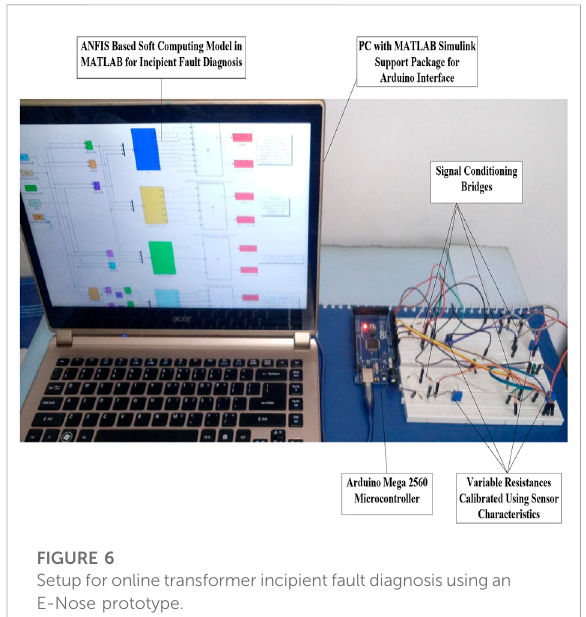
FIGURE 7 Communication between host computer and Arduino